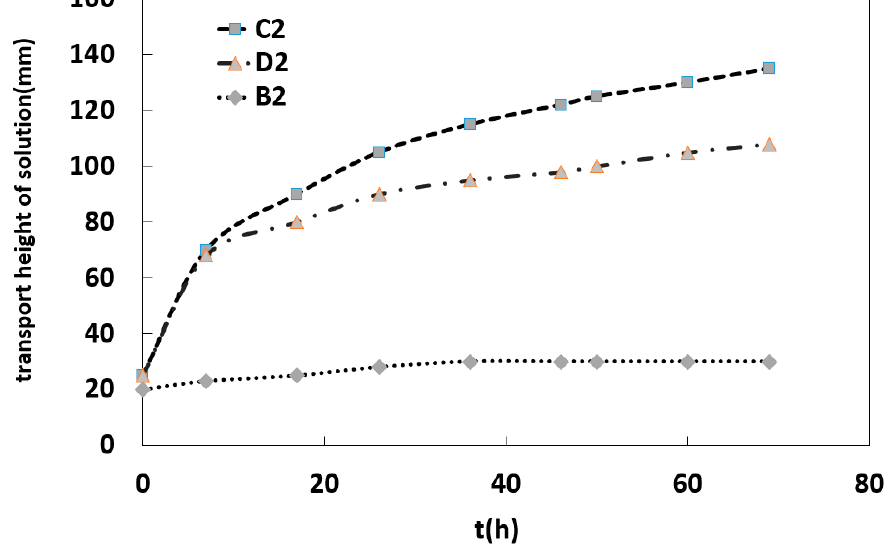
Figure 3. Capillary rising-rate curve of salt solution in samples.